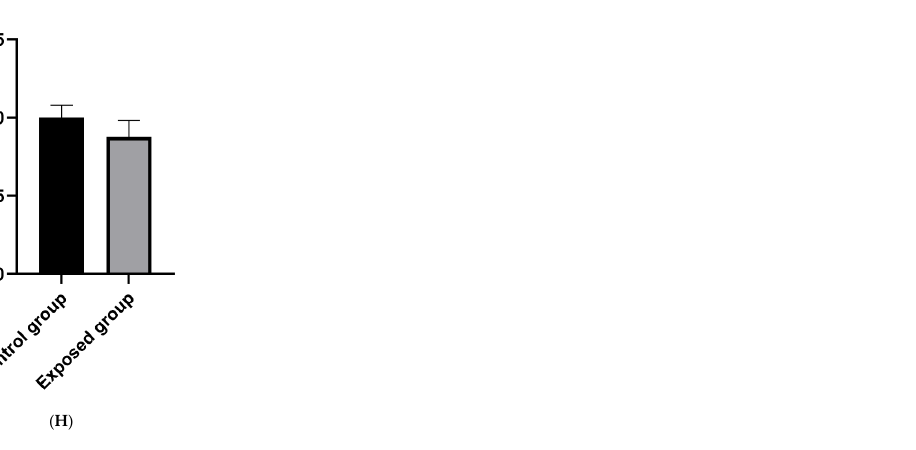
Figure 8. Oxidative levels of testicular tissue and mitochondrial structural and functional damage after the first recovery. ( A ) ROS level; ( B ) MDA level; ( C ) Expression of mitophagy protein; ( D ) Expression of mitophagy regulatory proteins; ( E ) Mitochondrial membrane potential; ( F ) Expression of mitochondrial fission and fusion proteins; ( G ) Mitochondrial genetic characteristics; ( H ) ATP contents. The data are expressed as the mean ± SD (n = 8) and analyzed by dependent sample t -test.